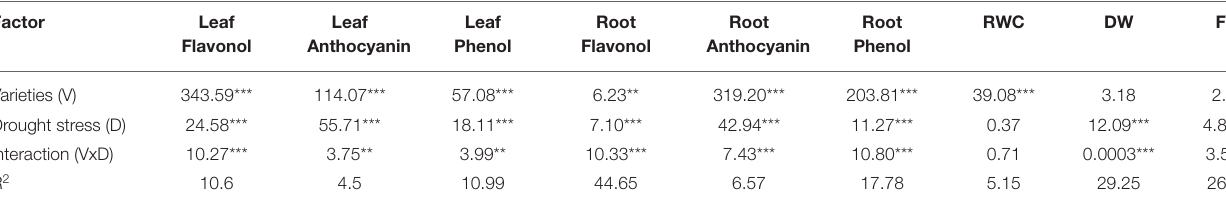
TABLE 1 | ANOVA for metabolites of peanut genotypes under drought stress.